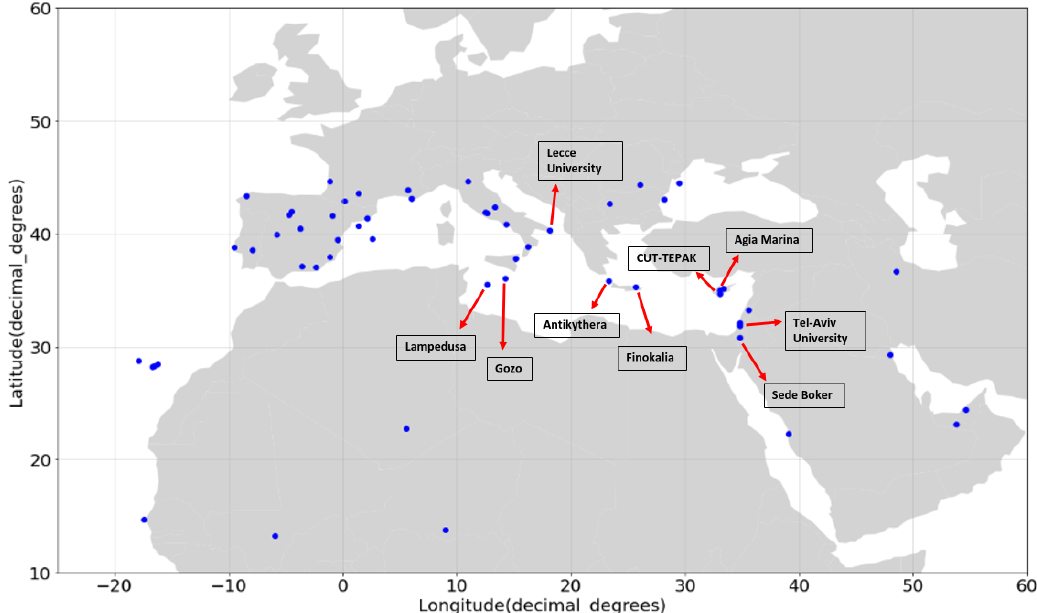
Figure A4. Map of all the AERONET stations within the constructed domain with available observations for the period of 18 September to 1 November 2020 used for the model evaluation. The stations used in the main text are those named and indicated with red arrows.